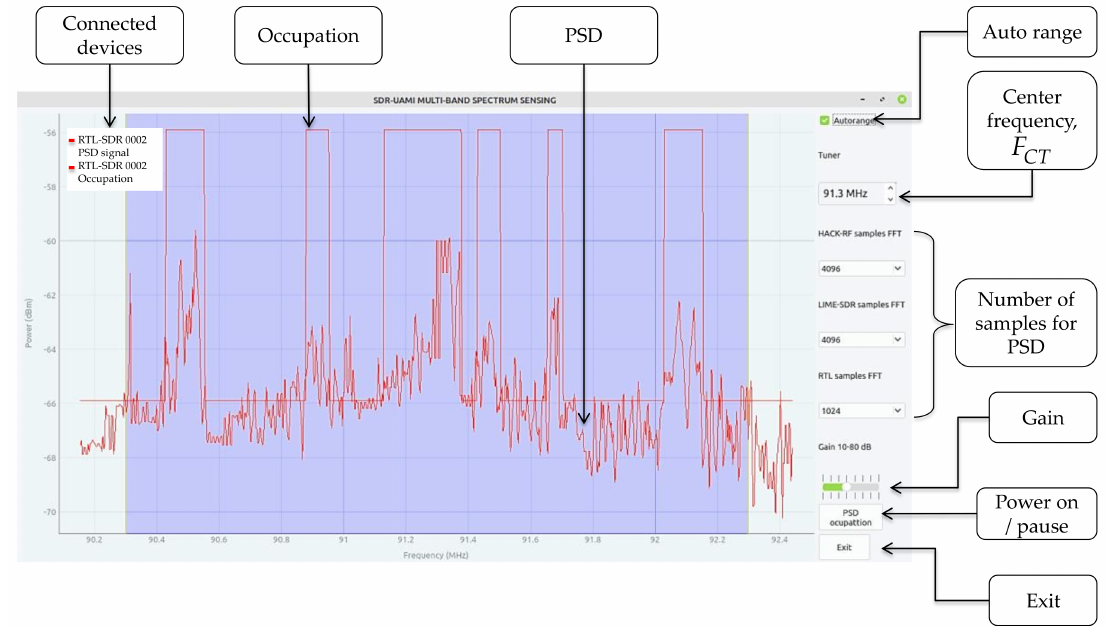
Figure 24. SDR–UAMI–MBSS